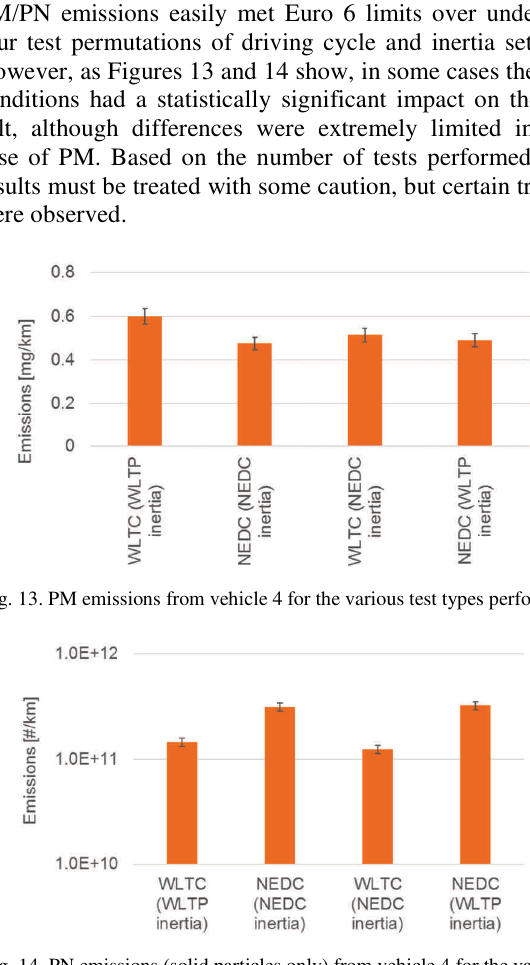
Fig. 14. PN emissions (solid particles only) from vehicle 4 for the various test permutations The WLTP at the (higher) WLTP-compliant inertia set- ting caused the highest PM emissions of just under